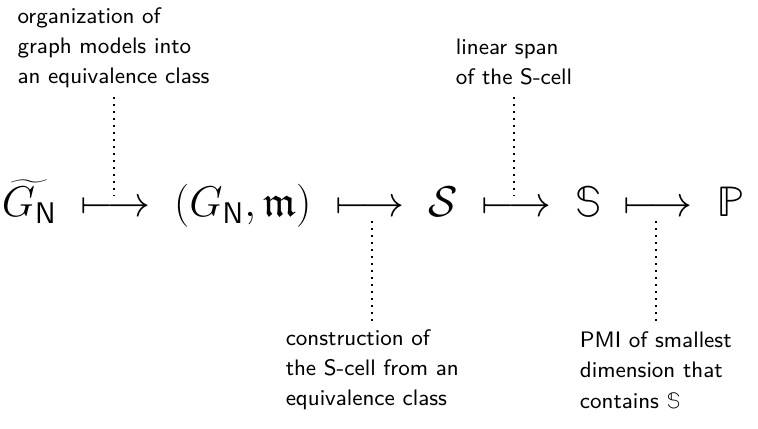
Figure 4. A summary of the various constructs that we have associated to graph models. Starting from a graph model f G N , each map along this chain associates to an object a coarser one. As we have exemplified throughout the text, none of these maps is